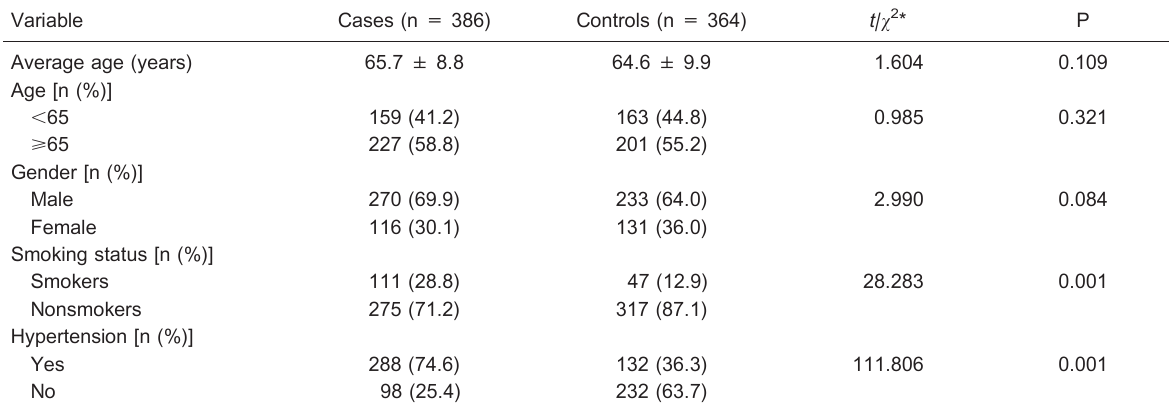
Table 1. Demographic and clinical characteristics of patients with ischemic stroke and controls.